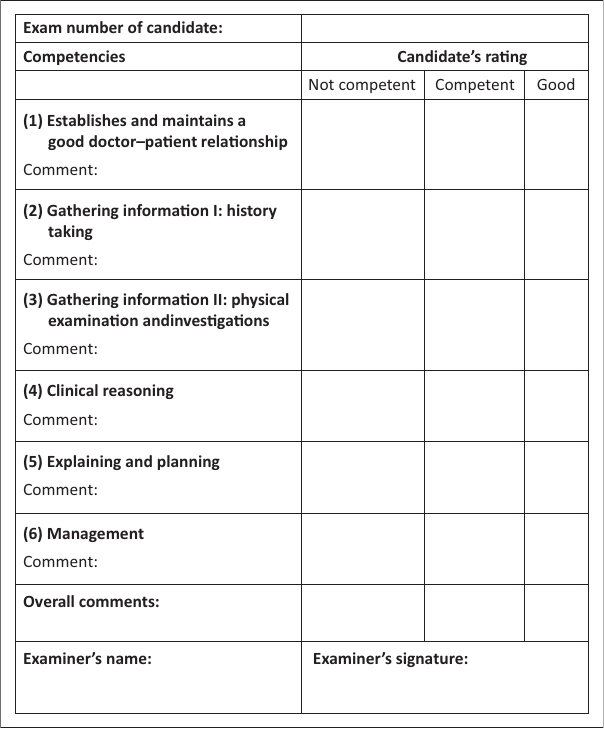
FIGURE 1: Marking template for consultation